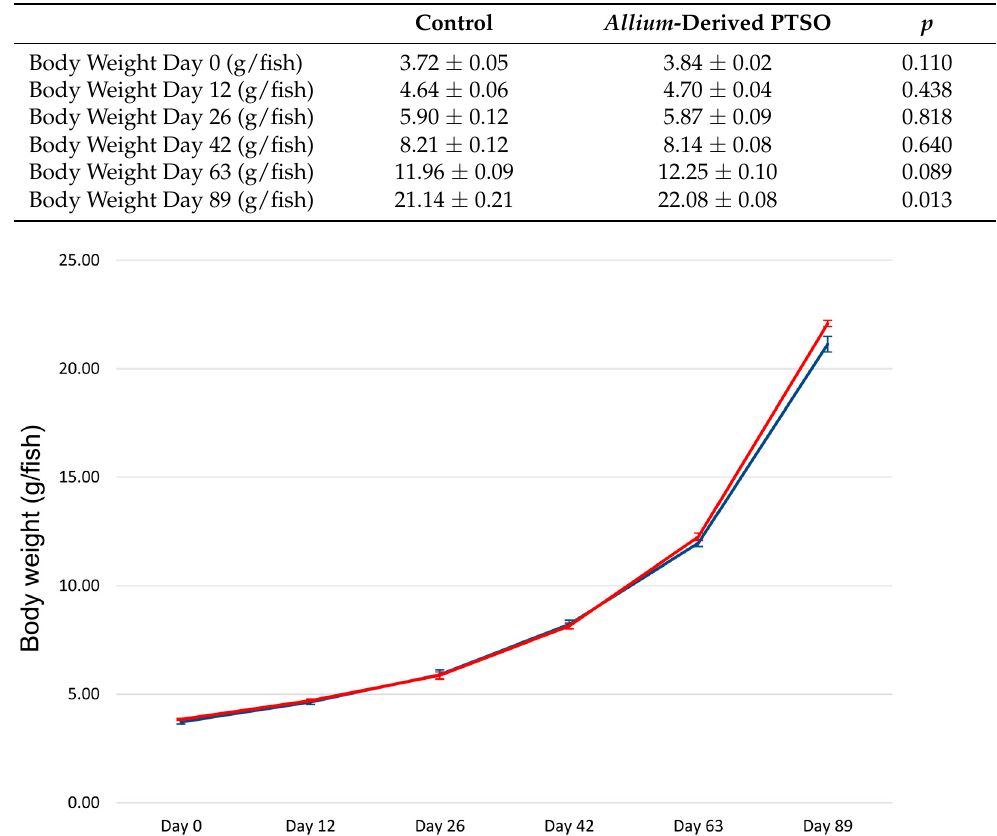
Table 1. General linear mixed models exploring the effects of diet in body weight in European seabass juveniles fed with a control diet or supplemented with Allium- derived PTSO along 89 days of experiment. Significant p -values are shown in bold.